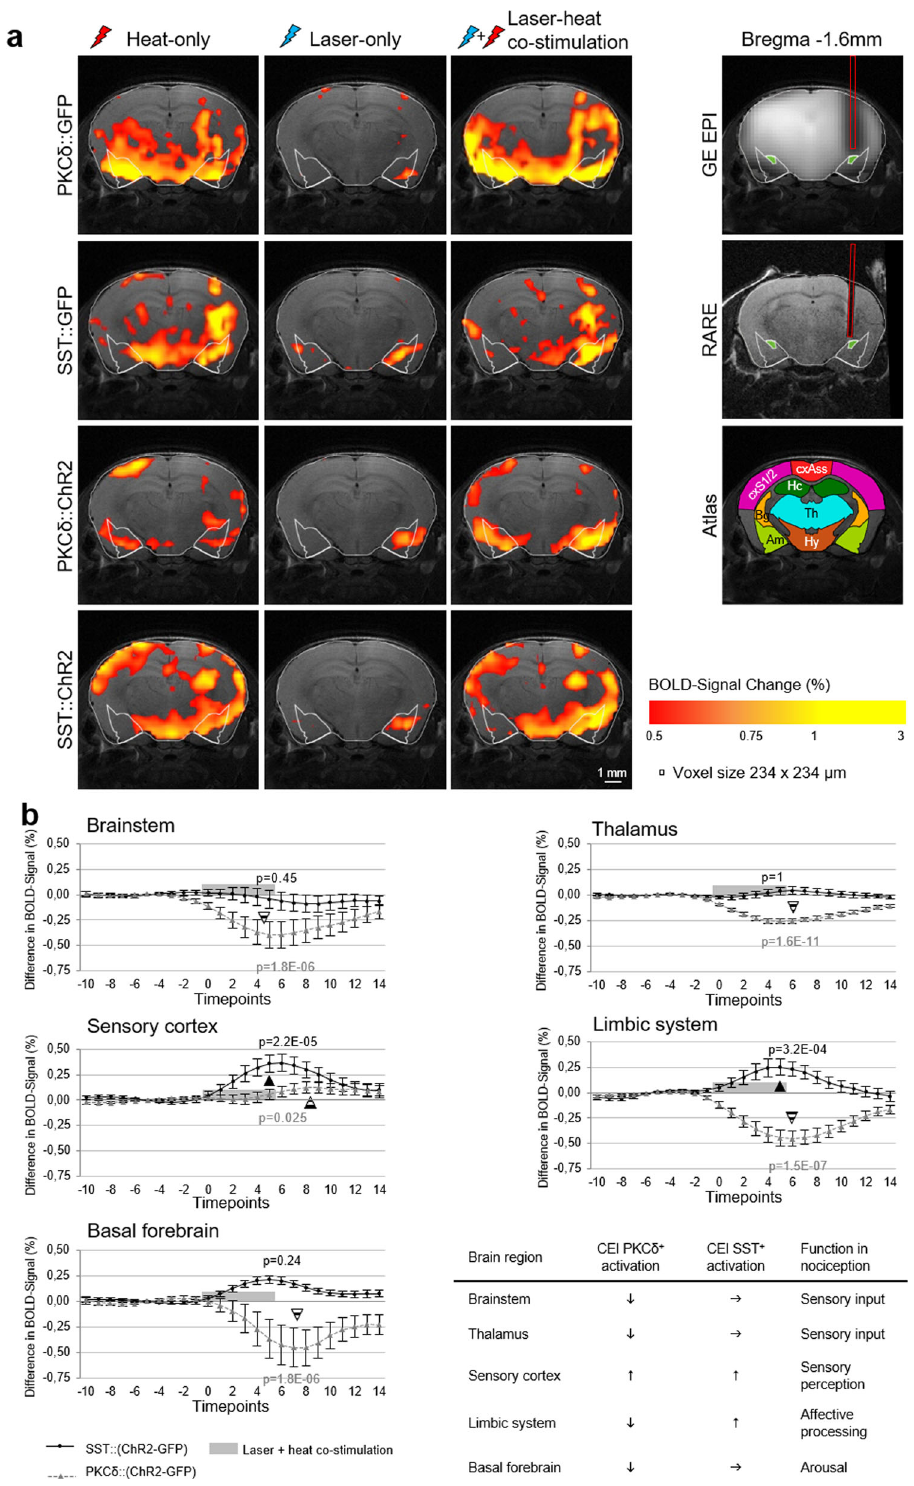
Fig. 6b, c). After saline injection, the average fi lament force evoking withdrawal did not differ between groups. However, after CNO injections, the required force for SST::M3 mice to react was signi fi cantly different from PKC δ ::M3 mice, while the required force for PKC δ ::M3 mice was signi fi cantly greater than PKC δ :: GFP or SST::GFP controls. We obtained a similar trend for